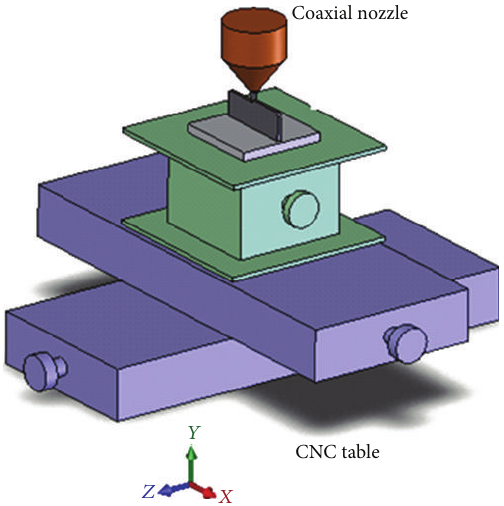
Figure 1: Schematic of the LDMD